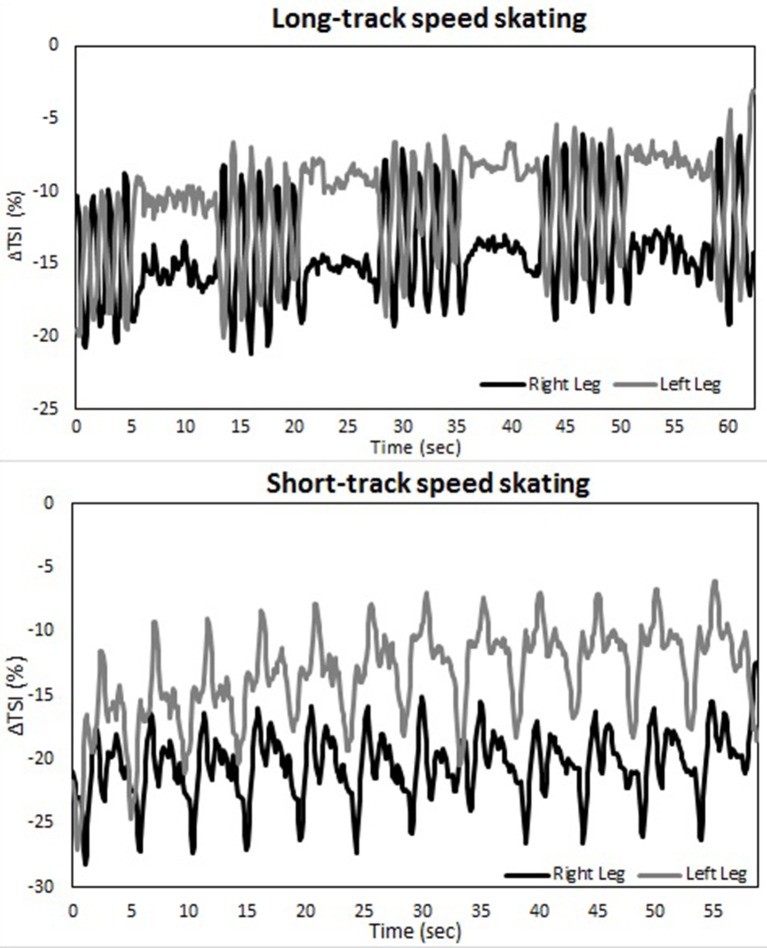
A typical example of the Δ tissue saturation index (%) during both a long-track (upper panel) as well as a short-track (lower panel) time-trial for one subject.